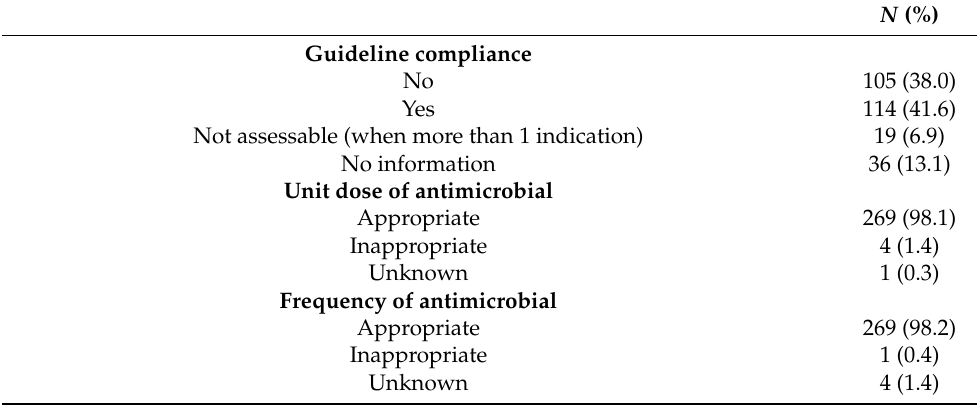
Table 3. Antimicrobial use